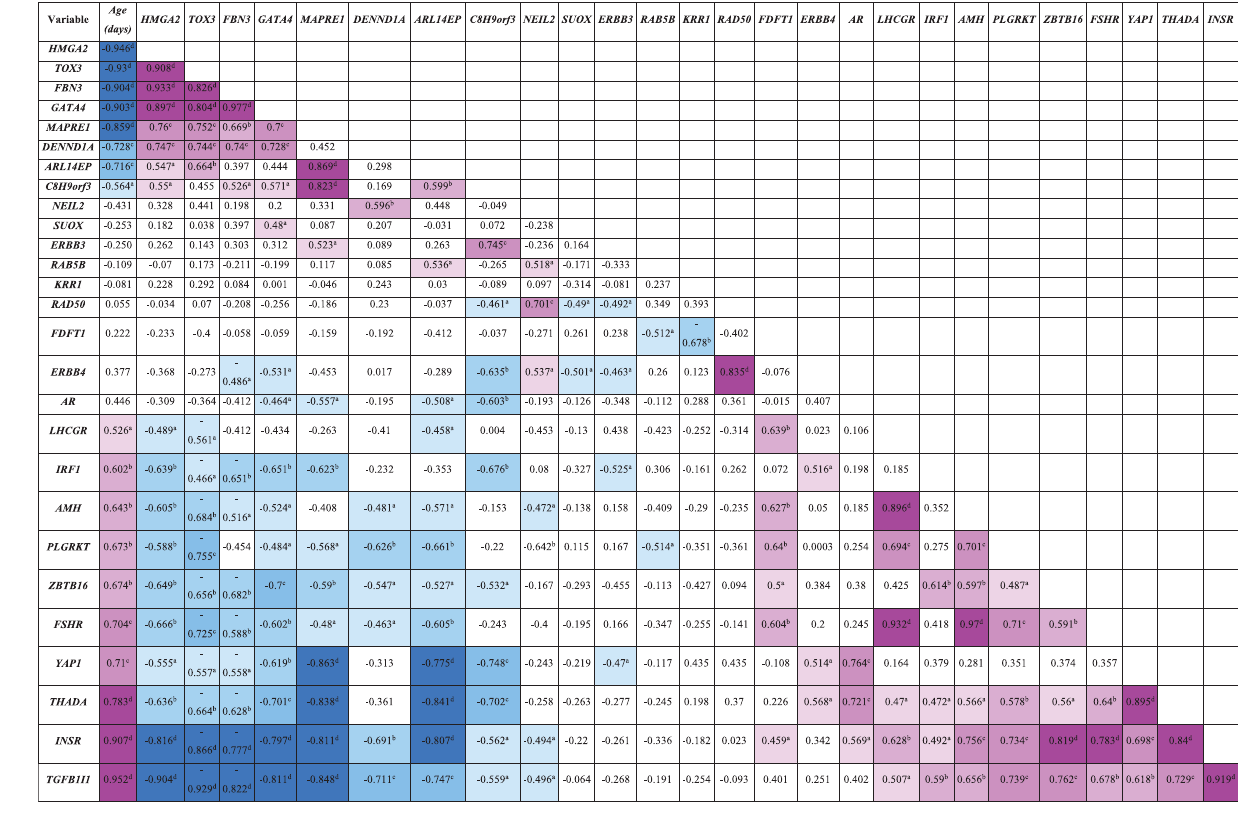
Positive and negative correlations are marked in pink and blue, respectively. The colour intensity correspondswith the strength of the correlation. p -values: a < 0.05; b < 0.01; c < 0.001; d < 0.0001.